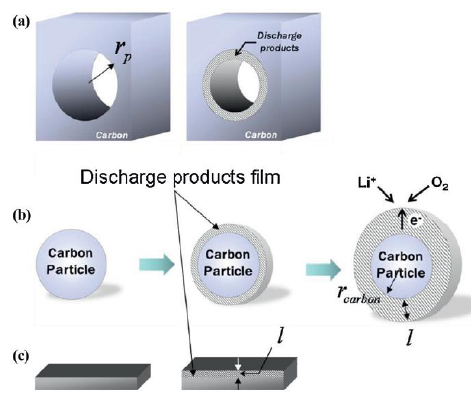
Figure 10. Various discharge product growth modes: ( a ) Cylindrical-film growth mode; ( b ) spherical-film growth mode; and ( c ) planar-film growth mode. Reprinted from Wang et al. [20], with permission from Elsevier.